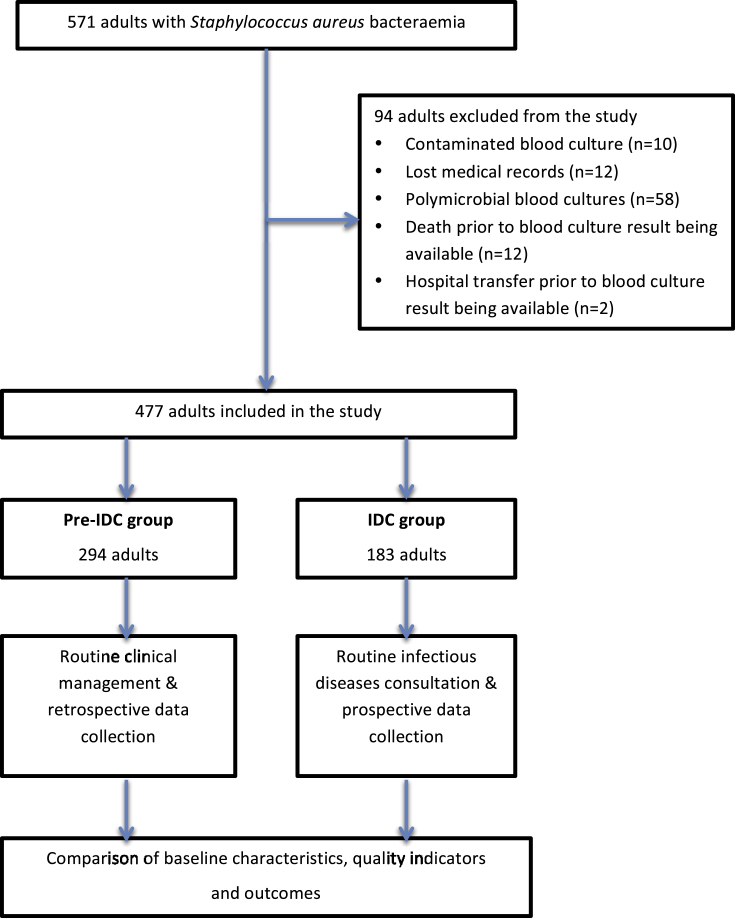
Flow chart of study participants.